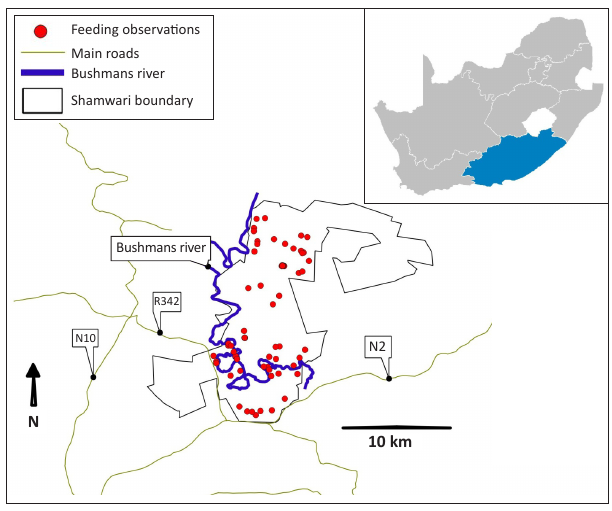
FIGURE 1: Locations of brown hyaena feeding observations by field guides in Shamwari Game Reserve, Eastern Cape Province during the study period, from